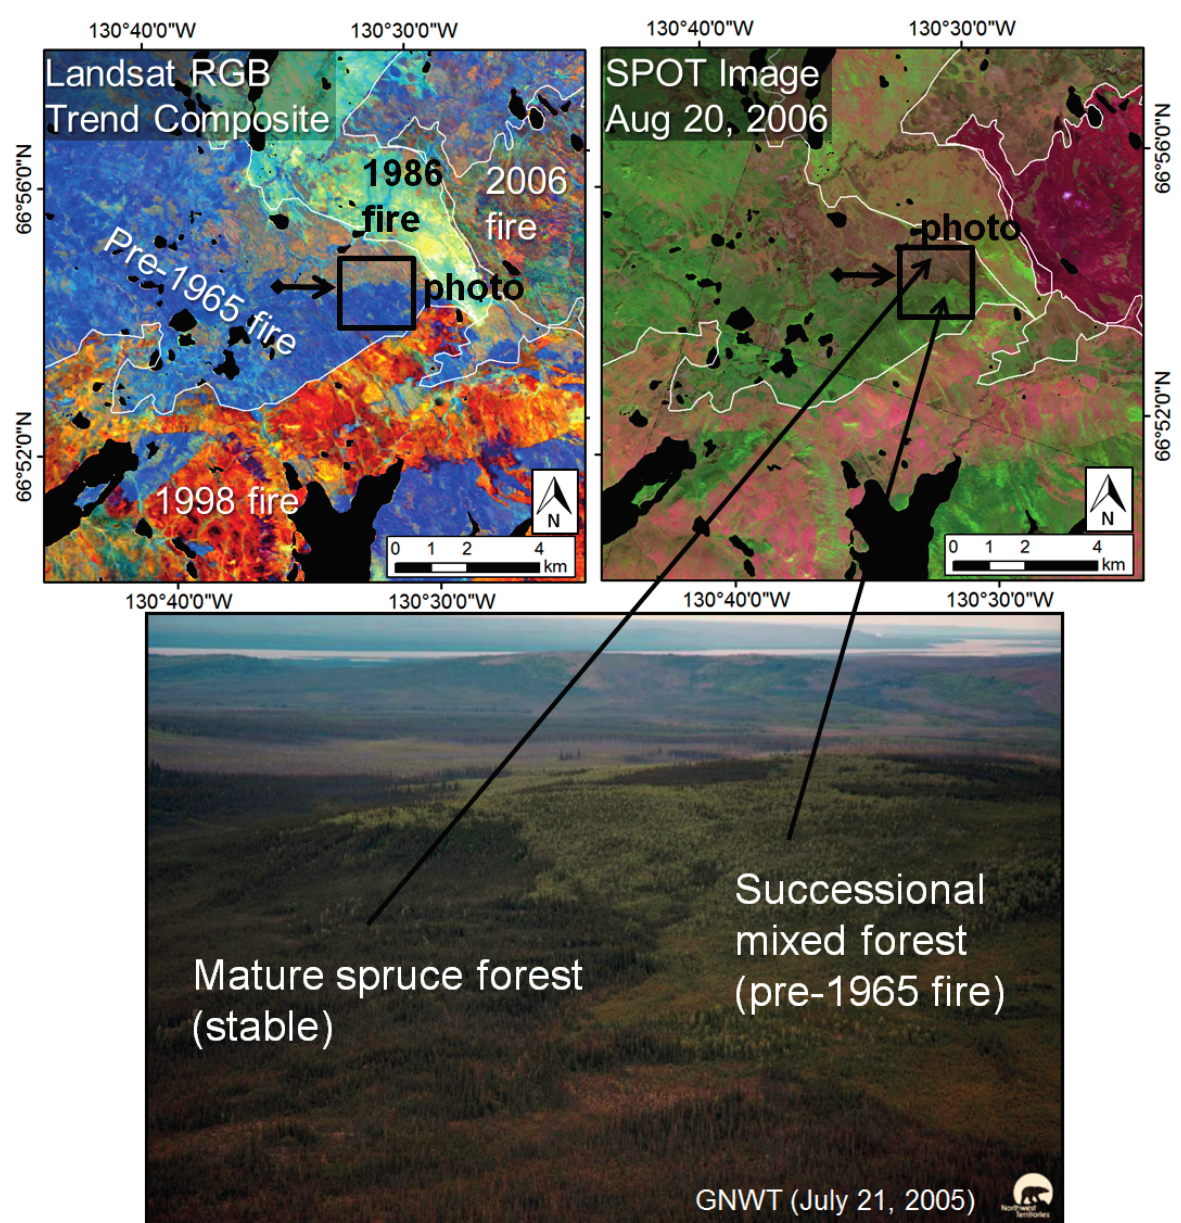
Figure 6. TC trend composite image ( top left ) showing the boundary between a mature forest and stand initiated following a pre-1965 fire, which is also observable in a 2006 SPOT Image ( top right ). The broadleaf-needleleaf composition of forest in the area is visible in a recent oblique air photo captured by the NWT Government ( bottom ). The small arrow shows the direction from which the photo was